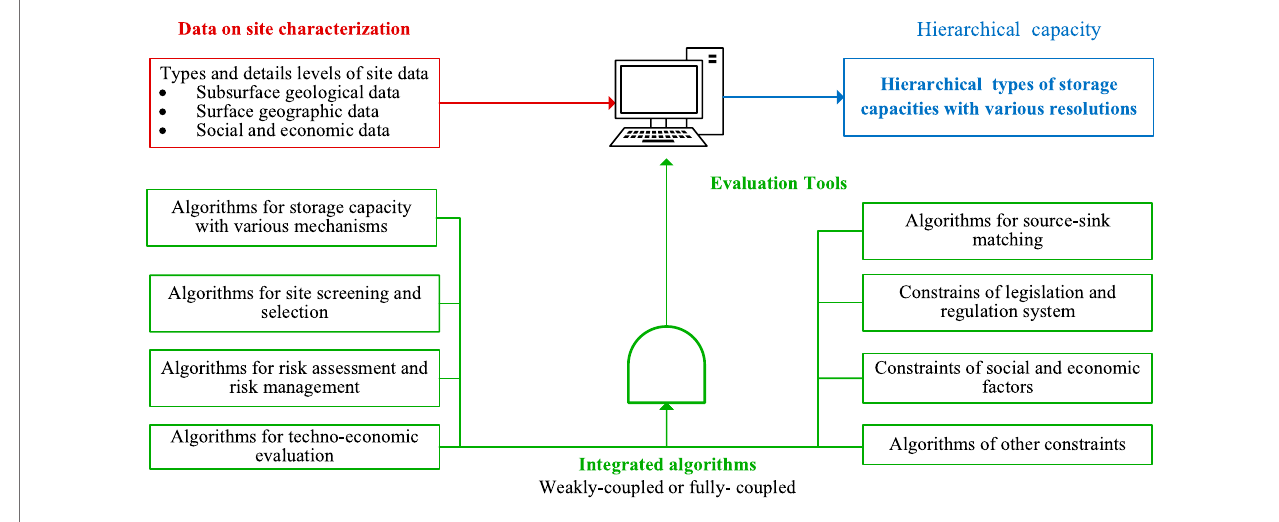
FIGURE 1 | Schematic graph of storage ef fi ciency coef fi cient and capacity evaluation.